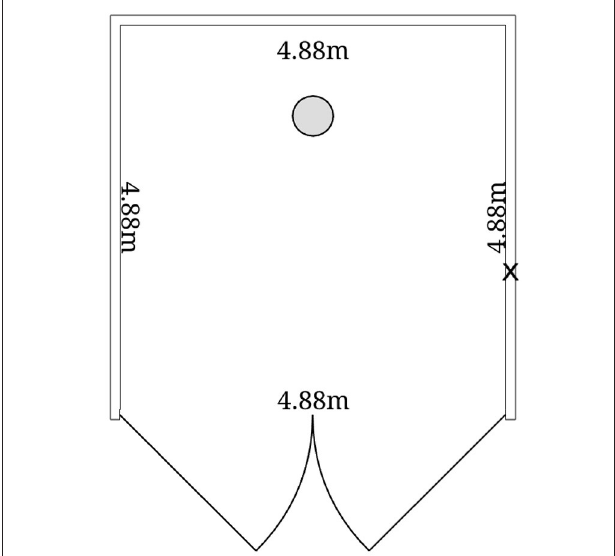
FIGURE 1 | Diagram and dimensions of the test arena which is an enclosed space with solid plywood walls bedded with wood shaving located in the calf barn. The circle in the diagram represents the location of the novel person and novel object. The X in the diagram represents where the umbrella is located during the startle test. The doors to the test arena are seen open at the bottom of the diagram, with the entrance in the middle of the